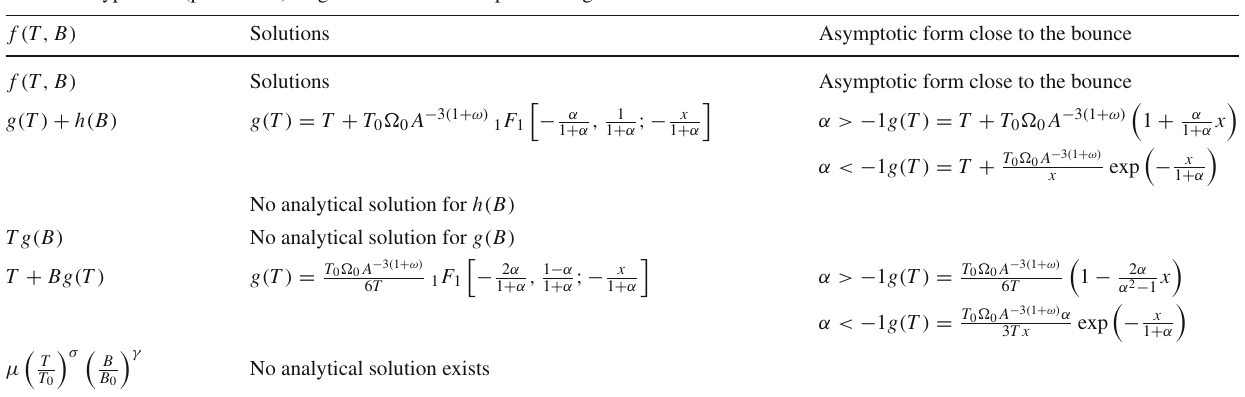
Table 10 A summary of the Lagrangian analytical solutions as well as their corresponding asymptotic forms close to the bounce for the Hubble parameter H ( t ) ∝ t α , which describes Type I–IV singularities as well as Little Rip cosmologies. Here, we have defined the parameter Model V: Type I–IV (past/future) singularities and little rip cosmologies